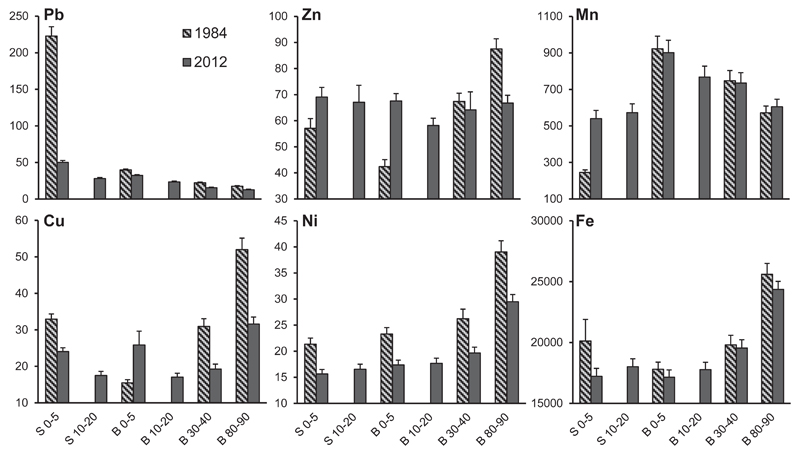
Mean soil contents of Pb, Cu, Zn, Ni, Mn and Fe (mg kg−1) in different soil depths of the stemflow area (S 0–5 and S 10–20) and the between trees area (B 0–5, B 10–20, B 30–40 and B 80–90) at 97 beech stands in 1984 and 2012. Error bars are ± S.E.